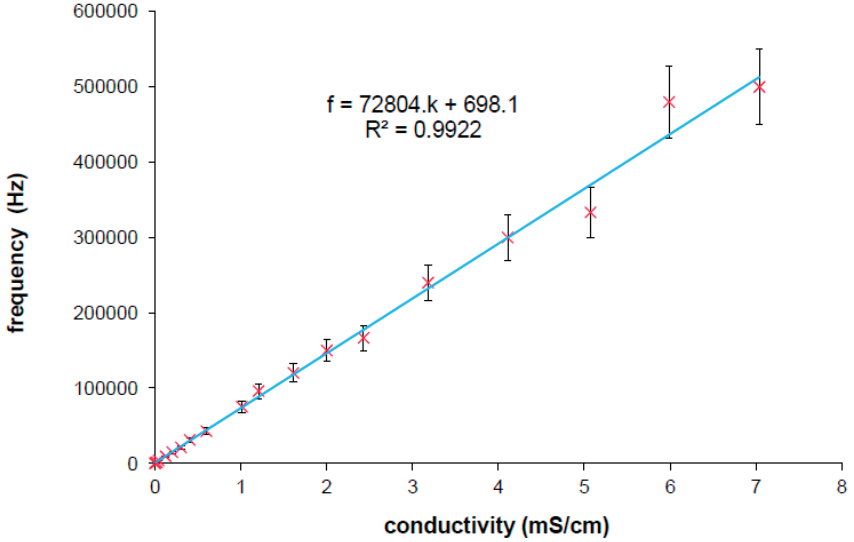
Figure 7. Linear dependence of frequency at local maxima on measured specific conductivity obtained from measuring various specific conductivities by IDEs [25]. Parameters for Equation (5) are determined from linear regression (inset of